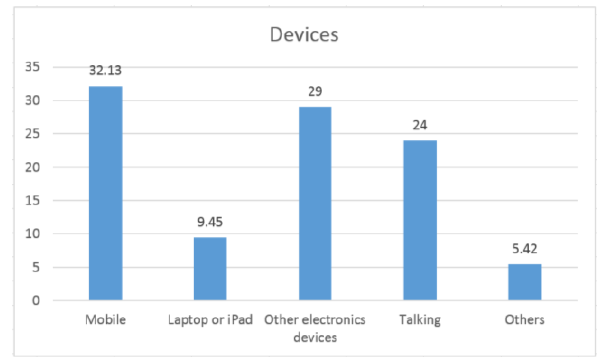
Figure 4. Devices.